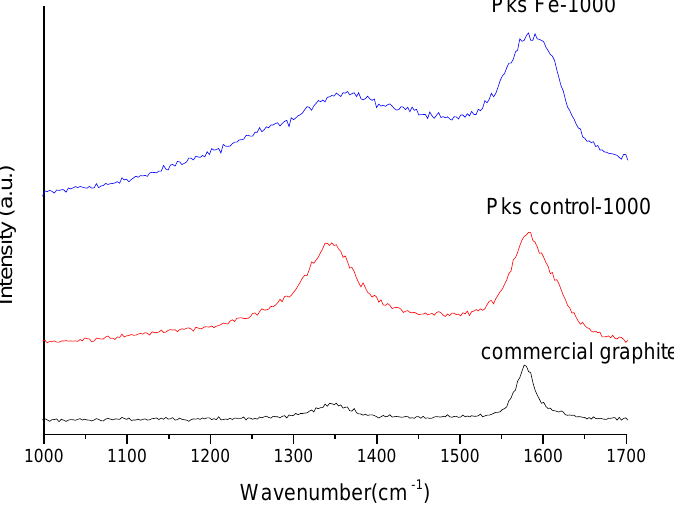
Figure 2. Raman spectra for Pks Fe-1000, PKS control and commercial graphite. A higher D/G peak intensity (I d /I g ) ratio reveals more structural defects in carbon material. As reported in Table 2, the I d /I g values for PKS Fe-1000, commercial graphite and PKS control-1000 were 0.985, 0.576 and 1.632, respectively. The I d /I g values were similar, as reported by a previous researcher, ranging between 0.84 and 0.98 I d /I g , with the utilization of lignin as a carbon source [20]. This further proved that thermal treatment at 1000 ◦ C and an iron catalyst successfully induced a high degree of graphitization into the palm kernel shell (PKS) waste. The ∆ ν G parameter and I d /I g value showed a descending order value for the PKS control, PKS Fe-1000 and commercial graphite. Lower ∆ ν G and I d /I g values for PKS Fe-1000 showed that the successful alteration of the amorphous material was achieved. The Raman spectra data are comparable with the XRD findings. In addition, the control sample showed the highest Id/Ig value of 1.63 compared to PKS Fe-1000 and commercial graphite, suggesting the presence of a turbostratic structure. Both analyses from the XRD and Raman suggested that the graphitic structure of the PKS waste was remarkably produced with the aid of an iron catalyst and thermal treatment at 1000 ◦